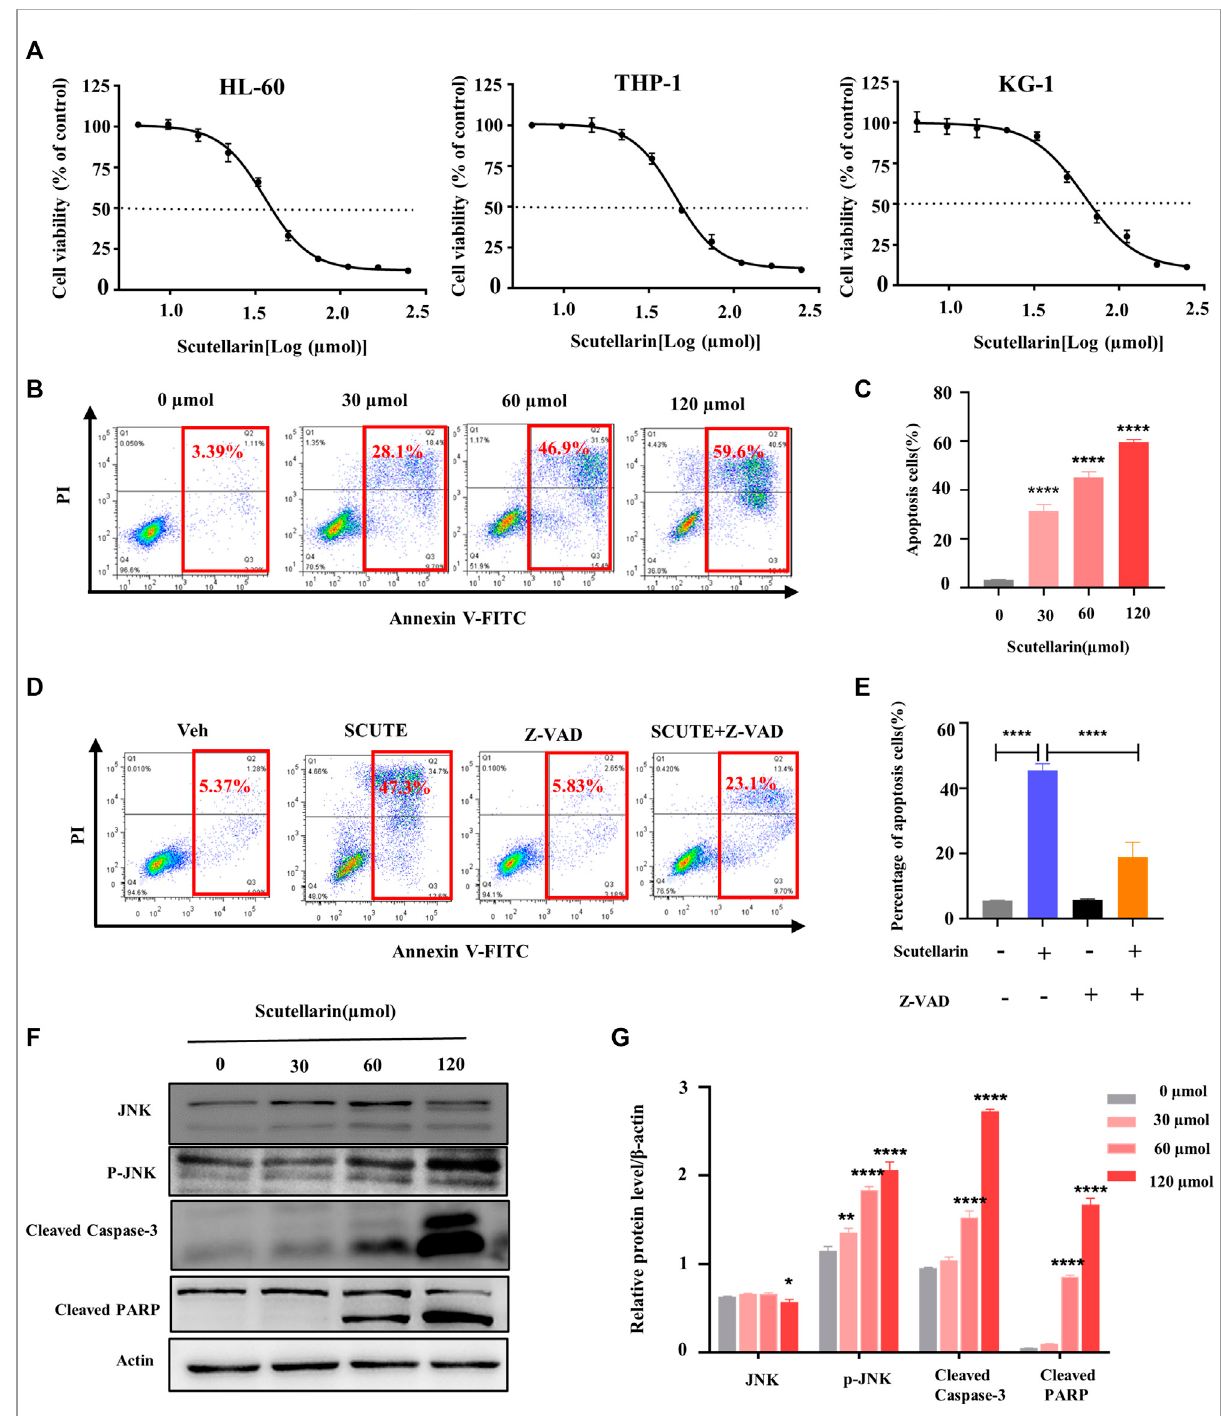
FIGURE 5 Scutellarin inhibits the growth of AML cells. (A) HL-60, THP-1 and KG-1 cells were treated with different concentrations of scutellarin for 72 h. Cell viability (% of control) was performed by CCK-8 assay. (B) Apoptosis analysis was measured by fl ow cytometry in HL-60 cells treated with differentconcentrations ofscutellarin. (C) The statistical analysis result of (B) . (D) Apoptosis analysis was performedby fl owcytometryinHL-60 cells incubatedwithvehicleorscutellarin(60 µM)for24 hfollowingpretreatedwithvehicleorZ-VAD-FKM(50 µM)for2 h. (E) Thestatisticalanalysis resultof (D) . (F) ThelevelsofJNK,p-JNK,cleavedcaspase-3andcleavedPARPinHL-60cellsafterscutellarintreatmentbyWesternblotanalysis. (G) The statistical analysis result of (F) . (H) Apoptosis analysis was performed by fl ow cytometry in HL-60 cells incubated with vehicle or scutellarin (60 µM) for 24 h following pretreated with vehicle or SP600125 (10 µM) for 2 h. (I) The statistical analysis result of (H) . (J) Western blot analysis of